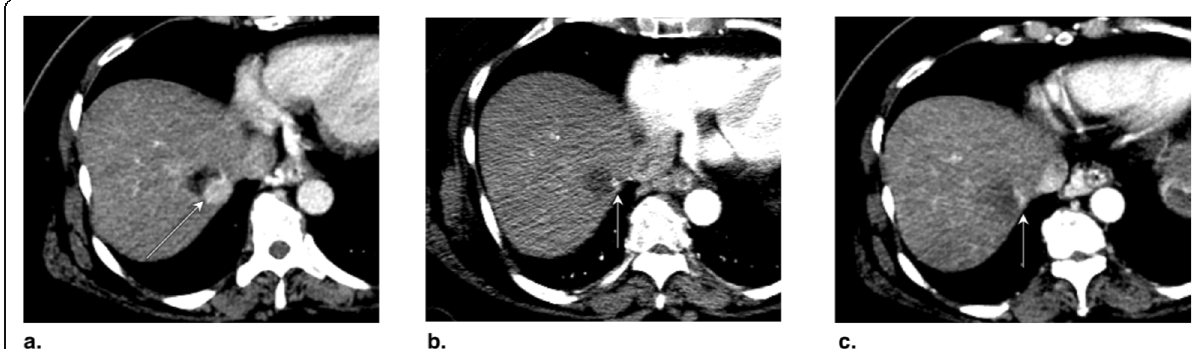
Fig. 25 Axial CT in late arterial phase obtained ( a ) pretreatment: image shows arterial phase hyperenhancement (APHE) of a nodule (arrow) within previous drug-eluting beads TACE (DEB-TACE) treatment zone. b 1 month post repeat DEB-TACE: image shows APHE of a 3 mm focus (arrow) at periphery of treatment zone. At this point, the treated observation is categorized LR-TR equivocal. c 4 months post repeat DEB-TACE: image shows enlarging 14 mm nodular APHE (arrow) at periphery of treatment zone. The treated observation is now categorized LR-TR Viable